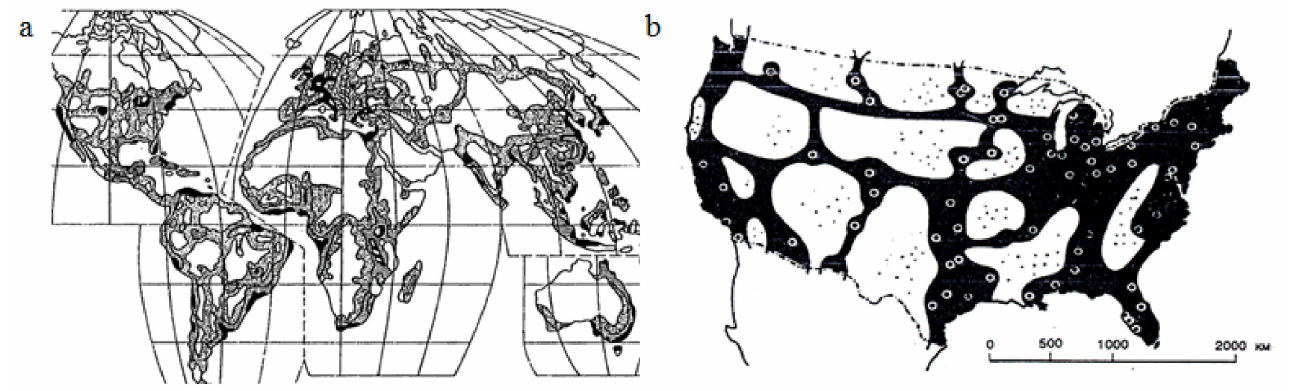
Figure 1. ( a ) Earth’s Ecumentopolis (forecast for 2100), according to K. Doxiadis [1,2]; ( b ) Ecumenop- olis in the United States (forecast for 2060), according to K. Doxiadis